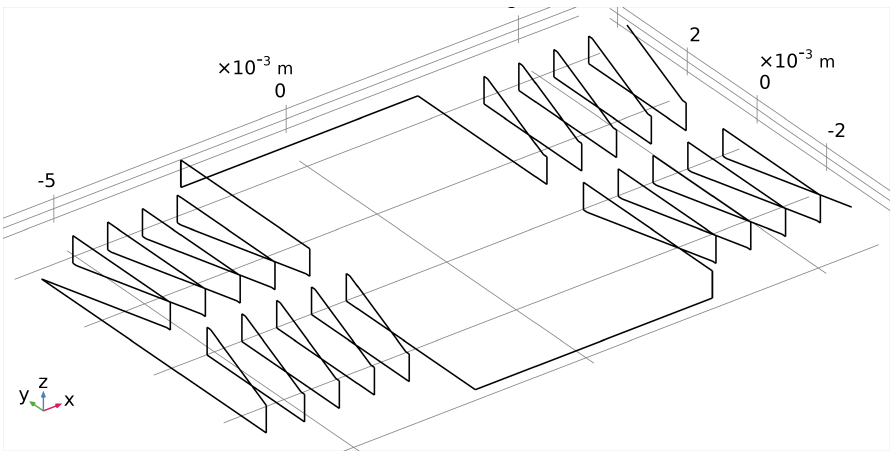
Figure 21. Filamentary model of the excitation oil used to calculate its frequency